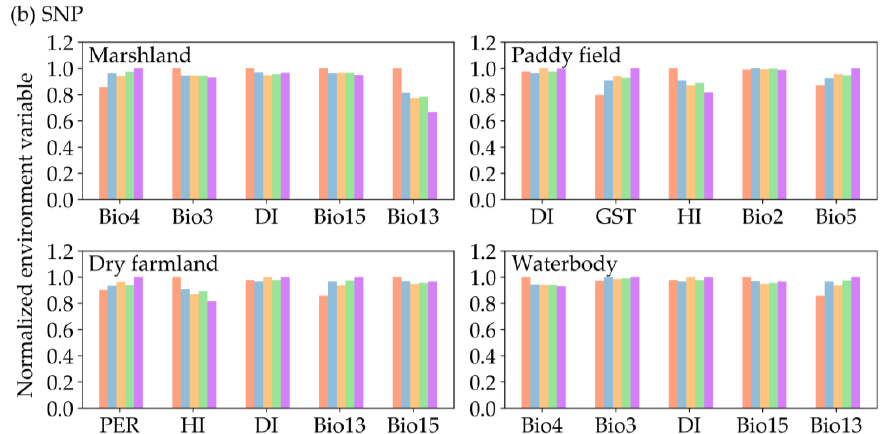
Figure 6. Variations of the TOP 5 normalized climatic environment variables under different climatic scenarios for each of the four LULCs of the: ( a ) SJP; and ( b ) SNP. The normalized values were calculated by dividing each variable with the maximum of the variable under different climatic change scenarios.